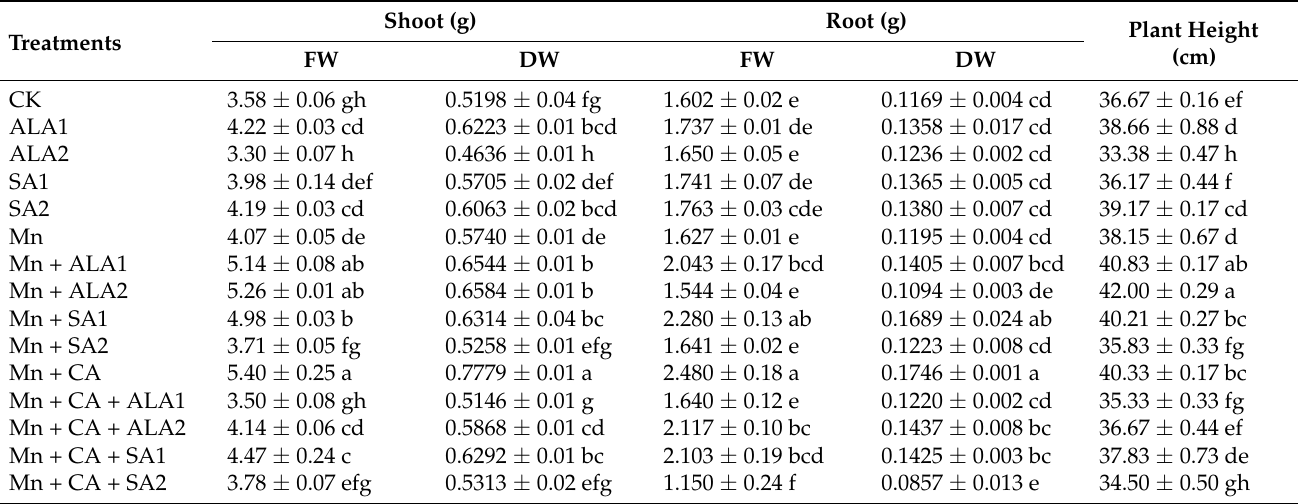
Table 1. Effects of 5-aminolevulinic acid or salicylic acid (ALA/SA) combined with citric acid (CA) on fresh weight (FW) and dry weight (DW) of shoot, root and plant height of sunflower plants under manganese (Mn)